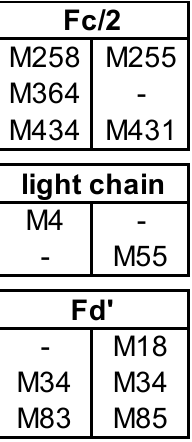
Figure 4. Methionine (M) positions for bevacizumab (left column) and infliximab (right column).